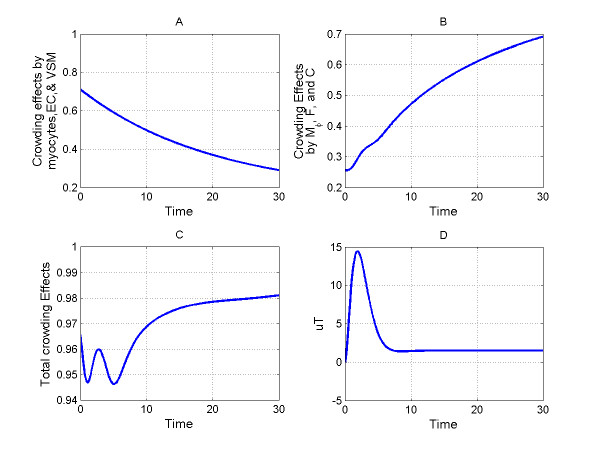
Plots of crowding effects (equation 2) and TGF-β1 activation function uT (equation 4). A: Crowding effects (kmem (t) in equation 2) contributed by myocytes, endothelial cells, and vascular smooth muscle cells. B: Crowding effects contributed by macrophages, fibroblasts, and collagen in the scar tissue. C: Total crowding effects imposed by the environment. D: TGF-β1 activation function, uT according to small scar size. Activation peak time is at day 2 post-MI with amplitude at 15 pg/μL/day.